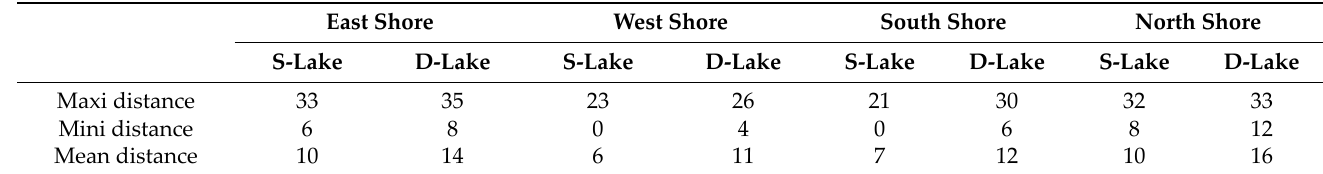
Table 5. Inland penetration distance (km) of lake breeze front at local time 14:00. East Shore West Shore South Shore North Shore S‑Lake D‑Lake S‑Lake D‑Lake S‑Lake D‑Lake S‑Lake D‑Lake Maxi distance 33 35 23 26 21 30 32 33 Mini distance Mean